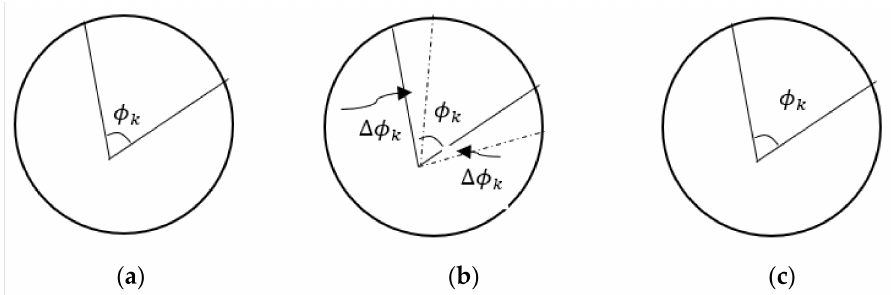
Figure 7. MC distributed coordination. ( a ) Before the coordination, ( b ) during the coordination, ( c ) after the